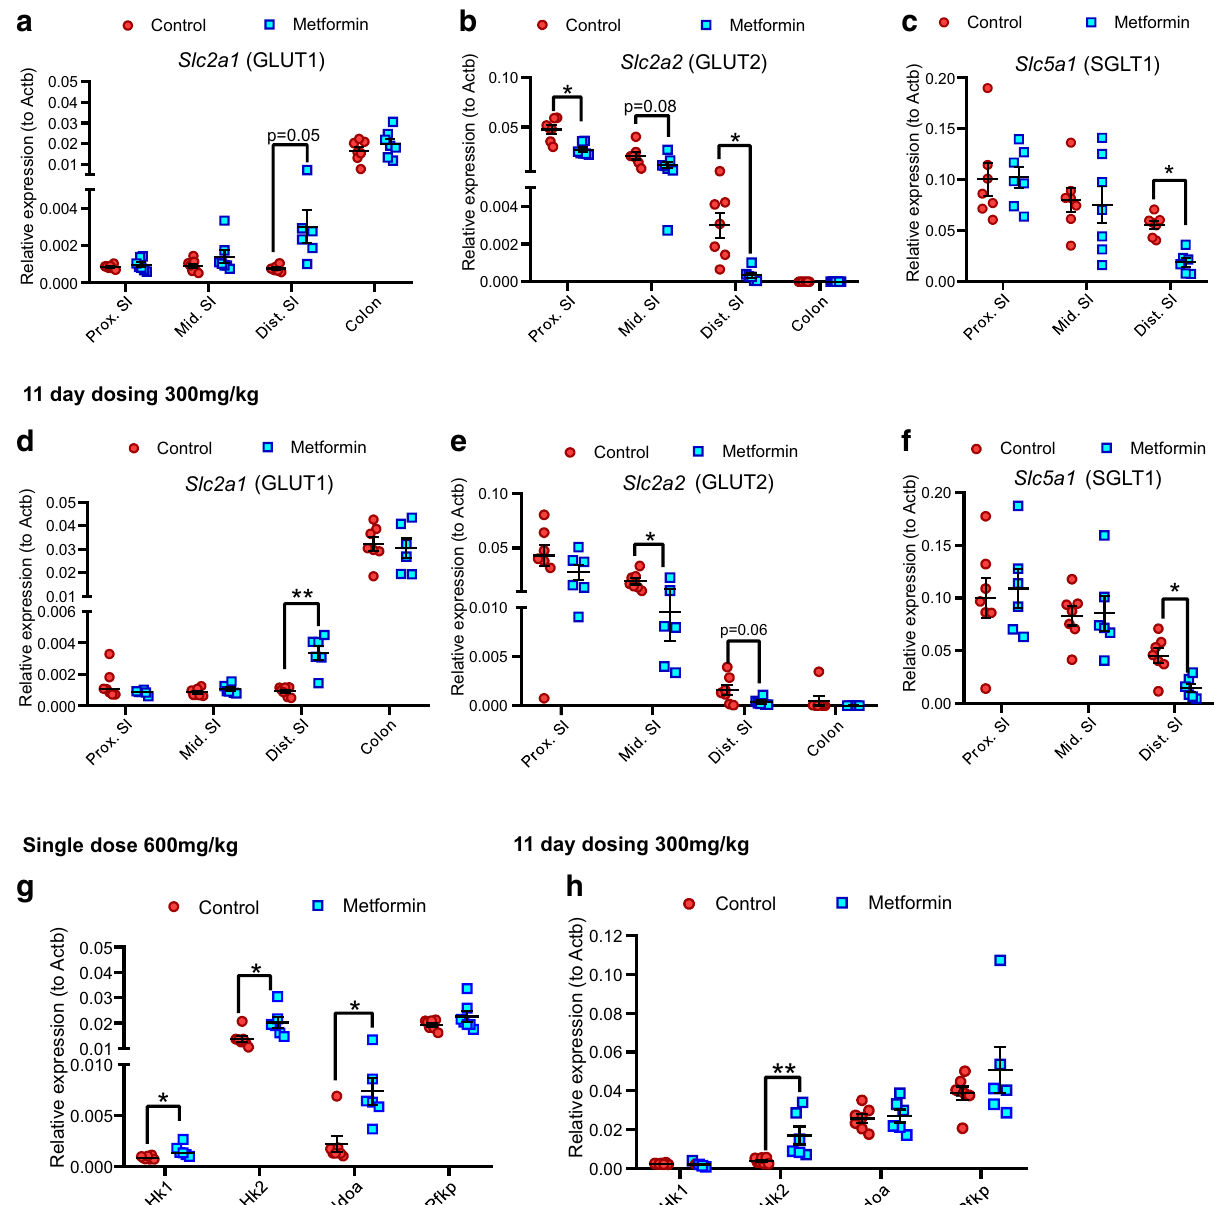
Figure 8. The effects of metformin on the expression of glucose transporters and metabolism genes in HFD-fed mice. ( a – c ) Effects of a single oral dose of metformin (600 mg/kg) on expression of glucose transporters Slc2a1 ( a ), Slc2a2 ( b ) and Slc5a1 ( c ) in proximal, middle and distal small intestinal and colonic tissues of HFD-mice. mRNA analysis of fresh frozen tissue normalised to expression levels of β-actin ( Actb ). Results are mean ± SEM. n = 6 mice per group. *P < 0.05, **P < 0.01, ***P < 0.001. Student’s t test. SI small intestine. ( d – f ) Effects of once daily oral administration of metformin (300 mg/kg) for 11 days on expression of glucose transporters Slc2a1 ( d ), Slc2a2 ( e ) and Slc5a1 ( f ) in proximal, middle and distal small intestinal and colonic tissues of HFD-mice. mRNA analysis of fresh frozen tissue normalised to expression levels of β-actin (Actb). Results are mean ± SEM. n = 6–7 mice per group (7 controls, 6 metformin). *P < 0.05, **P < 0.01. Student’s t test. ( g , h ) The effects of a single oral 600 mg/kg metformin dose ( g ) and once daily oral 300 mg/kg metformin dose for 11 days ( h ) on the expression of glucose metabolism genes Hk1 , Hk2 , Aldoa and Pfkp in the distal small intestine. Results are mean ± SEM. *P < 0.05, **P < 0.01. mRNA analysis of fresh frozen tissue normalised to expression levels of β-actin ( Actb ). Student’s t